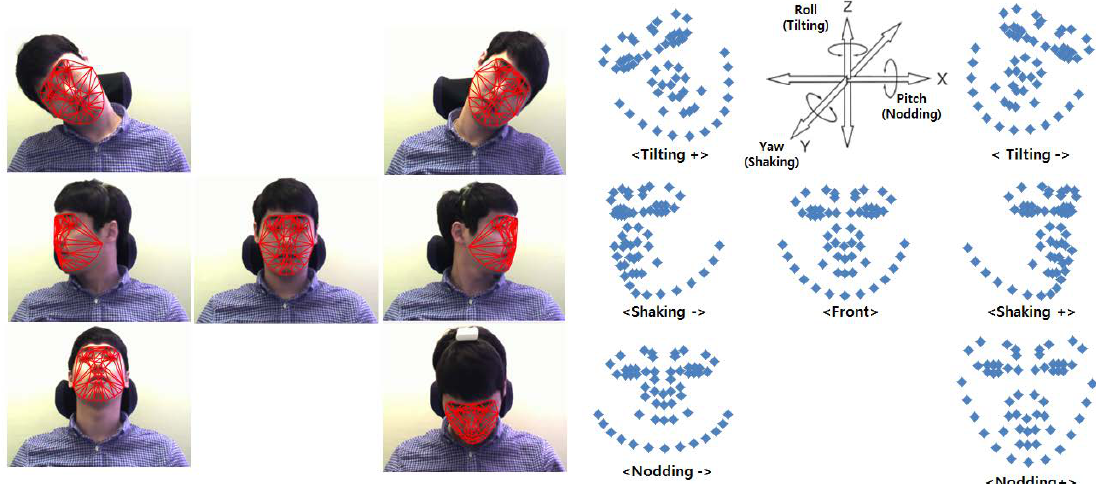
Figure 2. Pose Extended Active Shape Model (PE-ASM) is applied to the six extreme pose cases ( Left ) and their corresponding shape models are drawn ( Right ). Here, the ‘Front’ case covers the head rotation range from −30 ° to +30° in three different axis, and the other six cases cover the extreme head rotation occasions as given in Table 1.